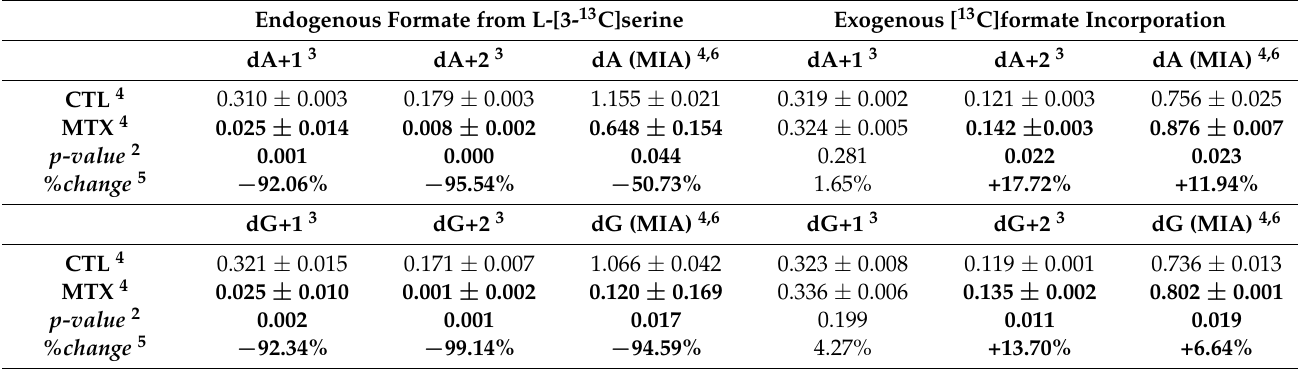
Table 1. Low-dose methotrexate (MTX) changes endogenous and exogenous formate utilization for nucleotide